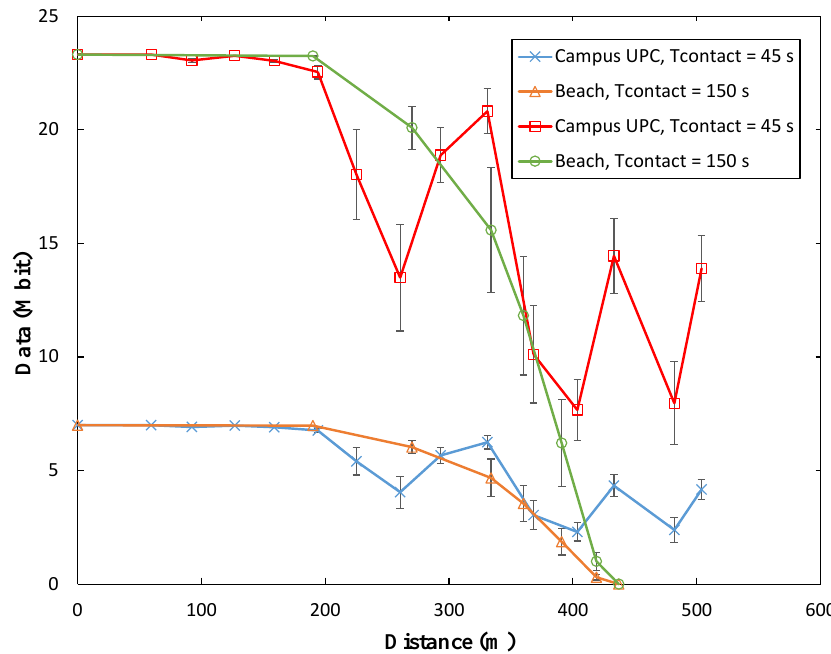
Figure 25. Measured amount of collected data as a function of distance between sender and receiver, in the university campus and beach scenarios.